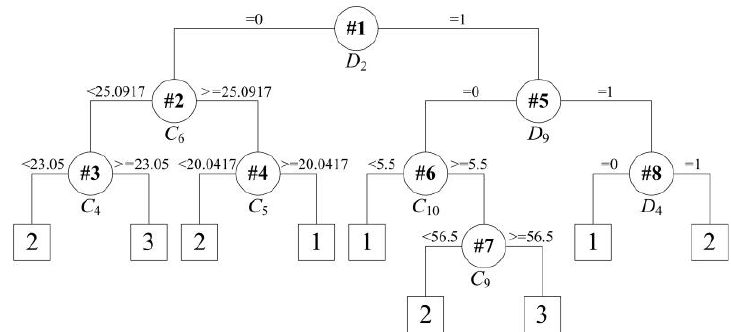
Figure 6. Tree structure for rule extraction on the dataset with correct classifications.